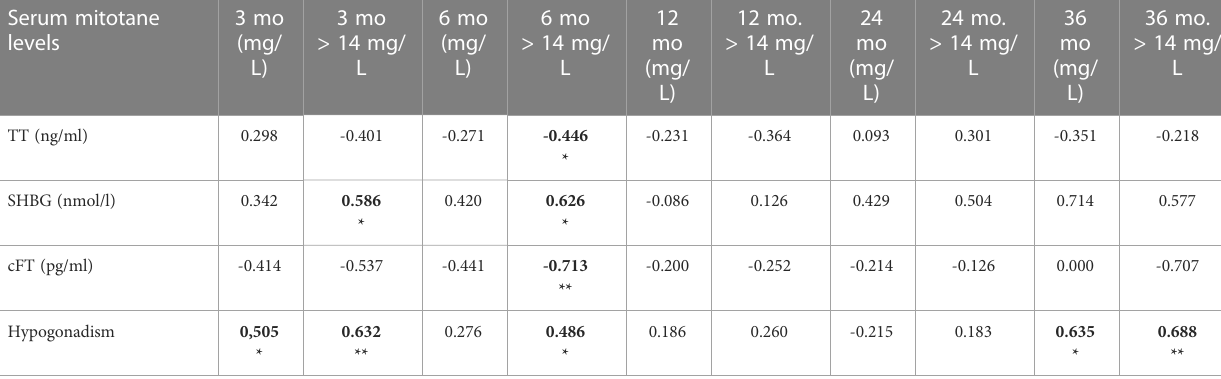
TABLE 4 Correlations between serum mitotane levels and gonadal function over time. Serum mitotane levels